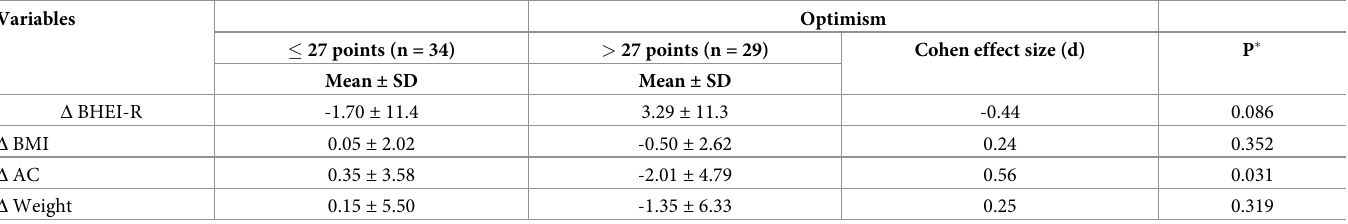
Table 7. Classification of optimism (dichotomized at the median) associated with the BHEI-R, BMI, AC and weight of patients with metabolic syndrome, Porto Alegre, Brazil (n = 63). Variables